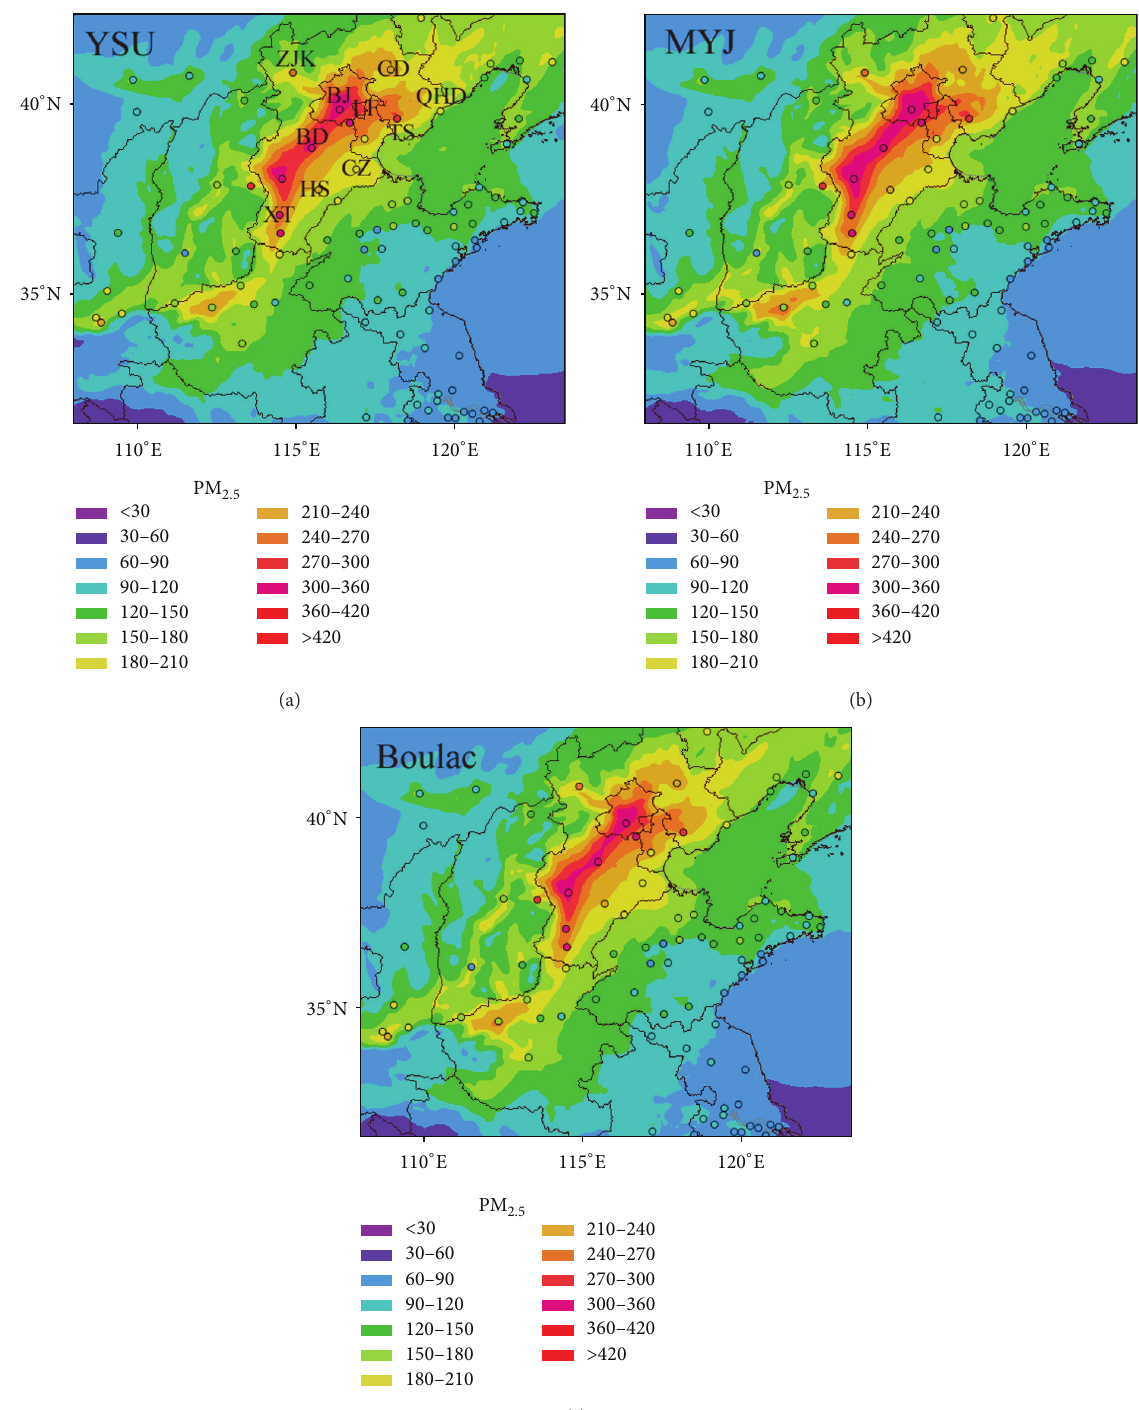
Figure 2: Mean simulated (shaded) and observed (circles) PM 2.5 values during the haze period (February 21 to 25).